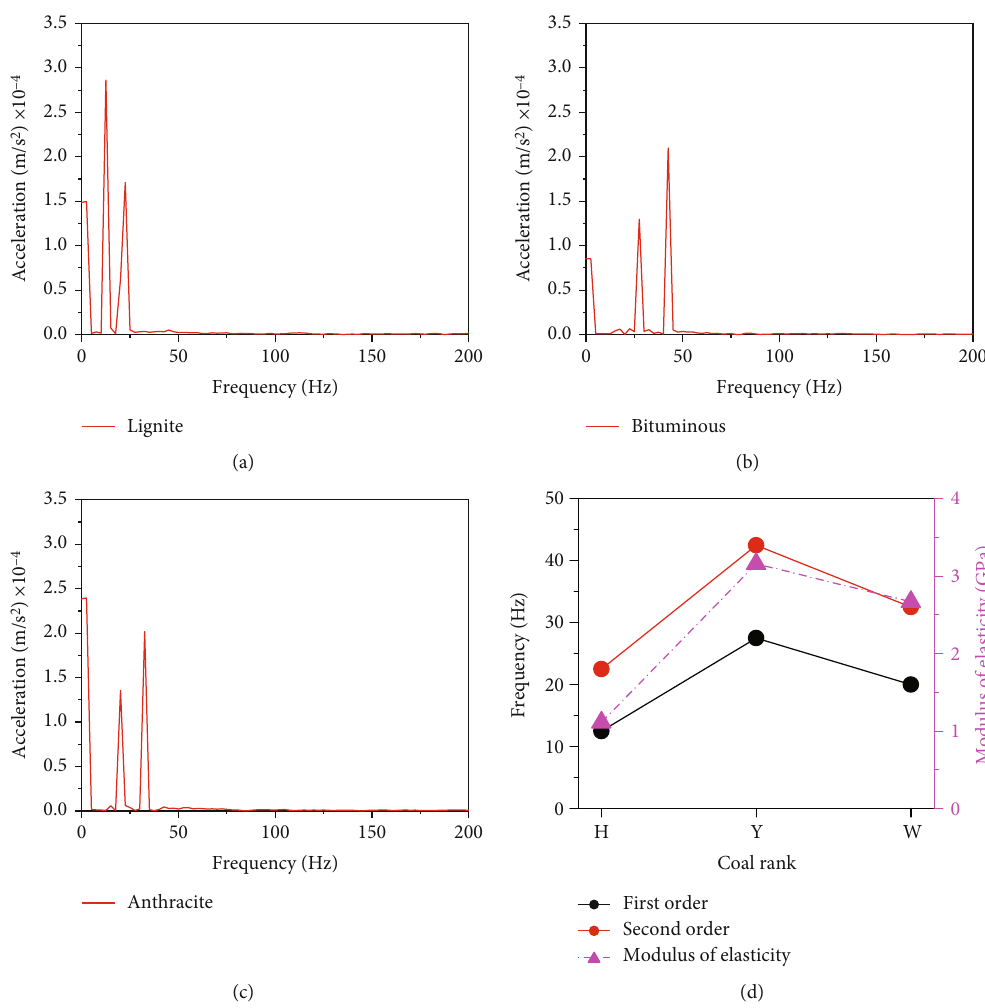
Figure 9: Frequency domain diagrams and natural frequency variation pattern diagram of di ff erent-rank dried lignite coal